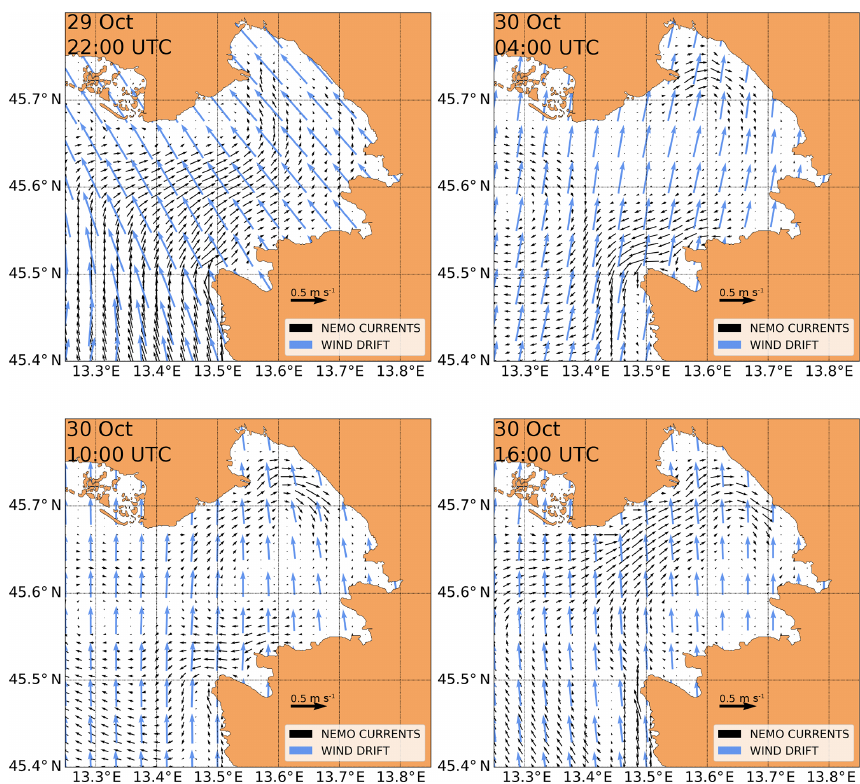
Figure 7. The 6-hourly same-scale snapshots of NEMO currents (black arrows) and ALADIN SI 10m wind u 10 induced wind drift (blue arrows) over the period of the windsurfer’s drift. Only purely downwind arrows with no crosswind departure from the ALADIN SI wind velocity direction are plotted, computed as a (cid:107) u 10 using OpenDrift person-in-water downwind slope a (cid:107) = 1 . 93%. Only every third wind point is plotted for clarity. Arrow lengths from both fields are commonly scaled and both arrow length units are metres per